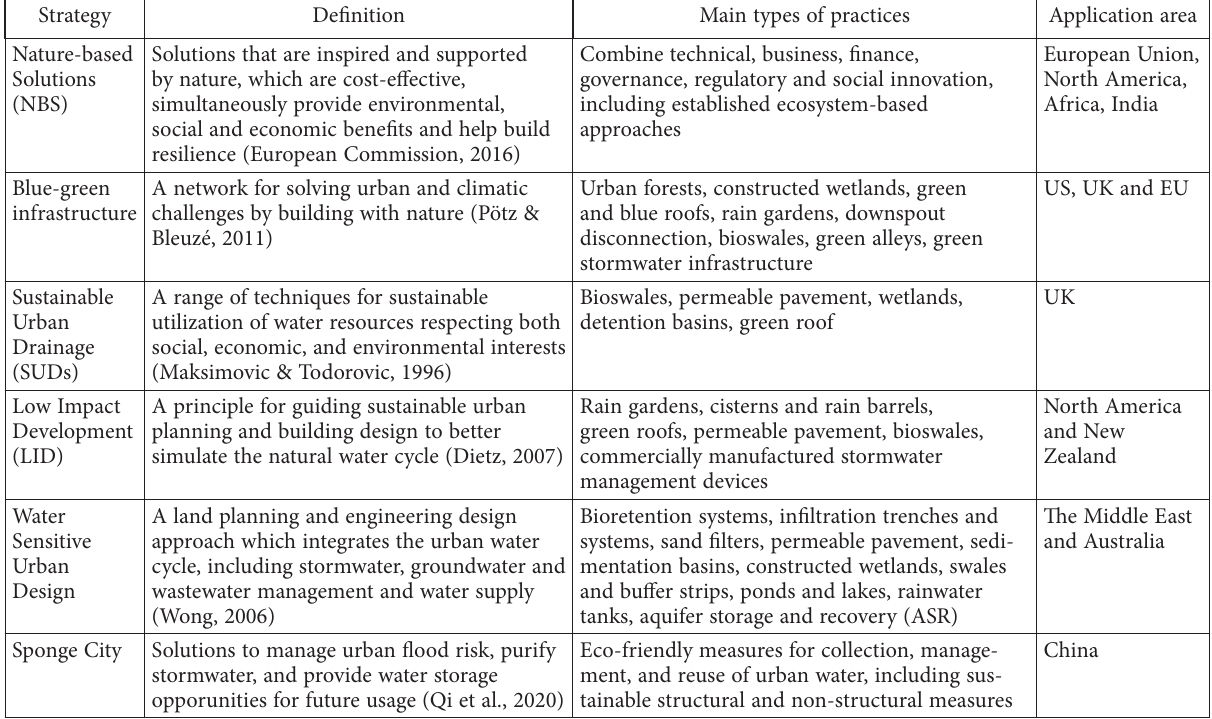
Table 2. Strategies related to landscape